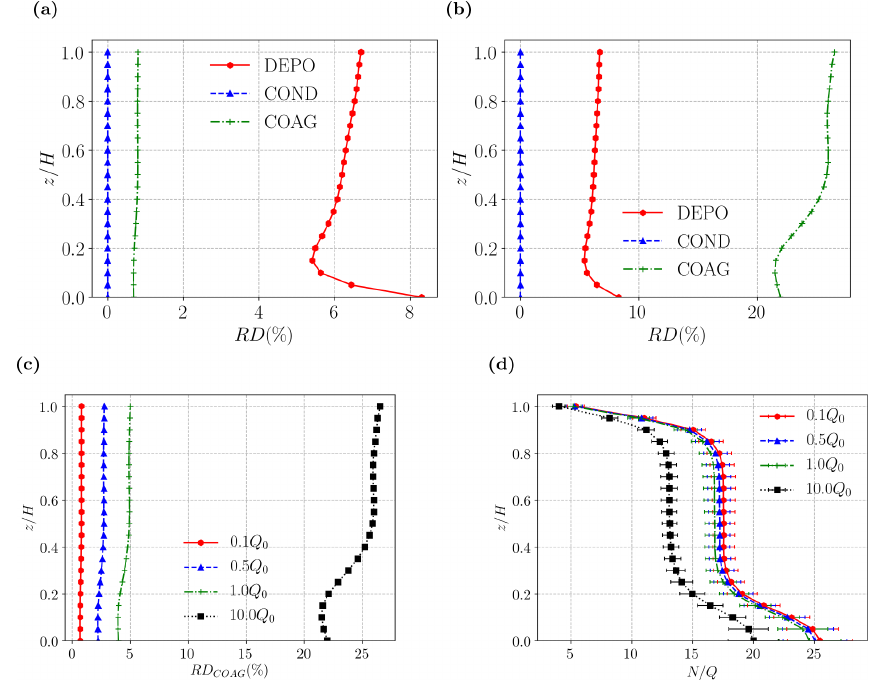
Figure 16. Comparison of aerosol processes and source fluxes, Q , for Case CO-B: panels (a) and (b) compare vertical profiles of RD i at fixed Q ; panels (c) and (d) compare the effect of different Q on coagulation. (a) Q = 0 . 1 Q 0 ; (b) Q = 10 Q 0 ; (c) RD COAG ; (d) normalised number concentration, N/Q